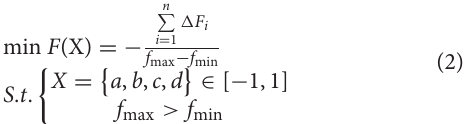
vertical substrate h = 25.0 mm and the thickness d 2 = 1.0